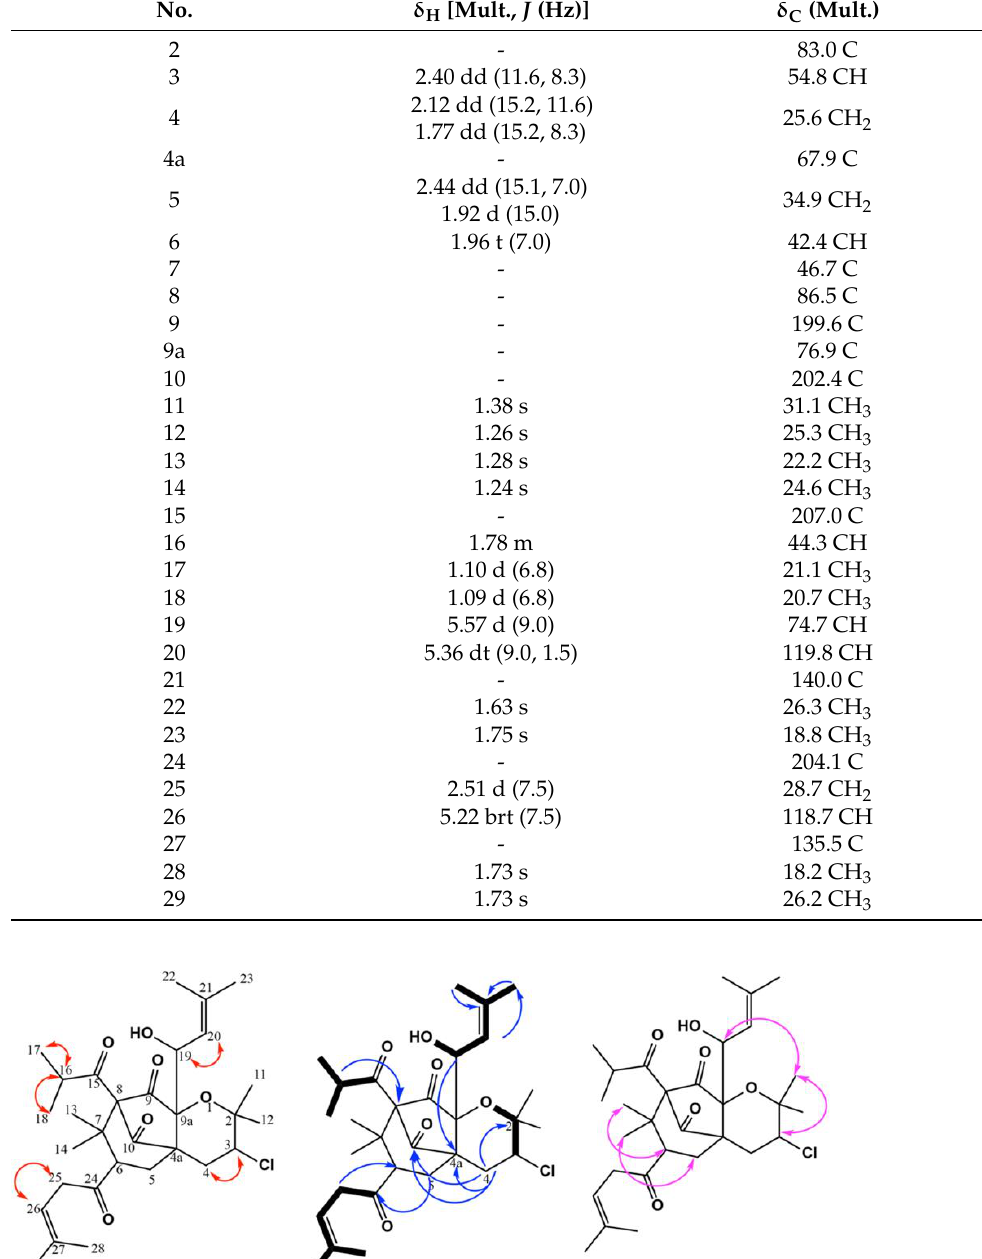
Table 2. NMR spectral data of compound 2 (CDCl 3 , 850 and 214 Hz).